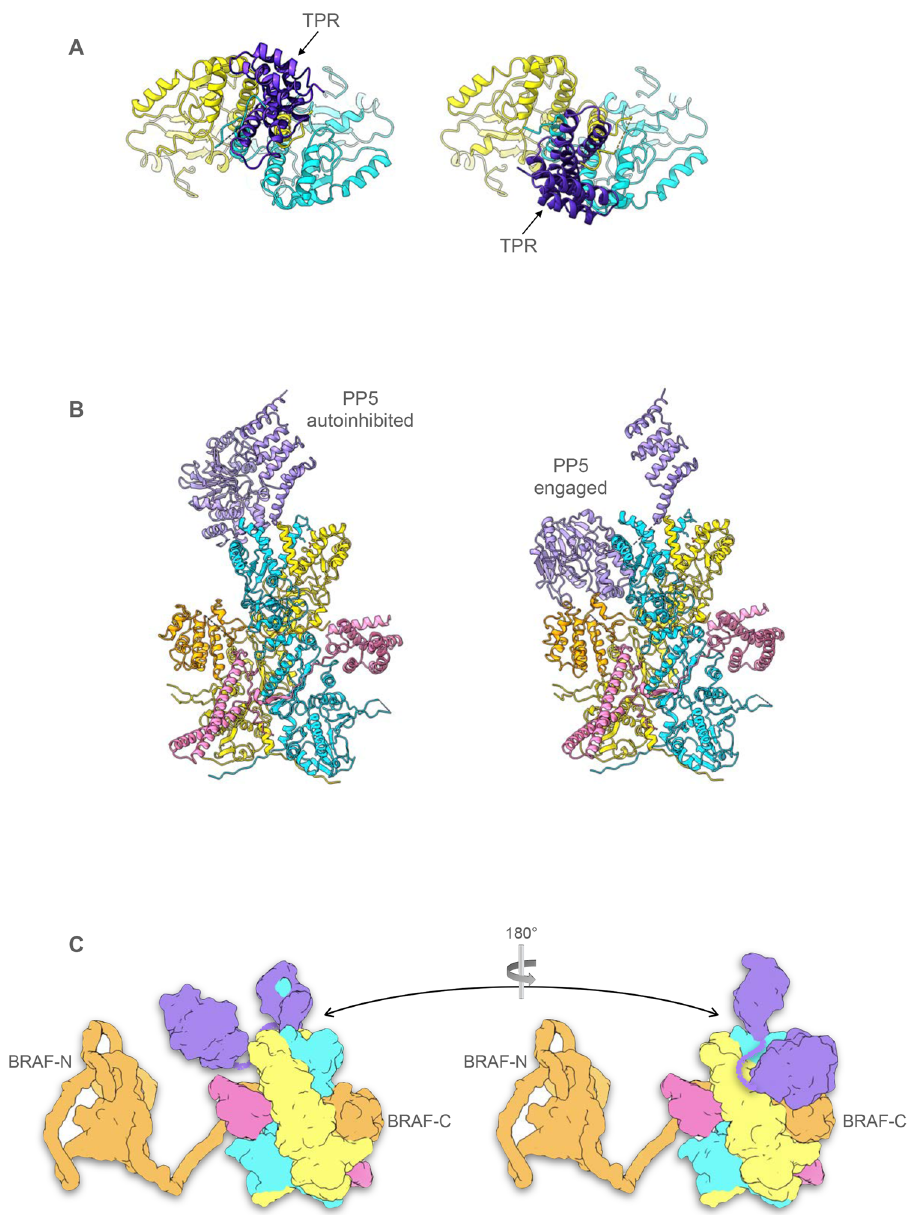
‘ closed ’ structure (see above),but withthe PP5component rotated to thesameside as the phosphatase in the experimental ‘ open ’ structure by the superimposition of the TPR domains. A movie illustrating the conformational switch between the ‘ closed ’ catalytically autoinhibited conformation and the ‘ open ’ substrate-engaged conformation is provided in Supplementary Movie 1. C By switching PP5 binding between the two TPR-binding sites on the HSP90 dimer, the fl exibly attached phosphatasedomaincanaccessphosphorylationsitesupstreamanddownstreamof the core interacting domain of the kinase client, taking advantage of the partly unfolded and ‘ linearised ’ state that binding to HSP90 – CDC37